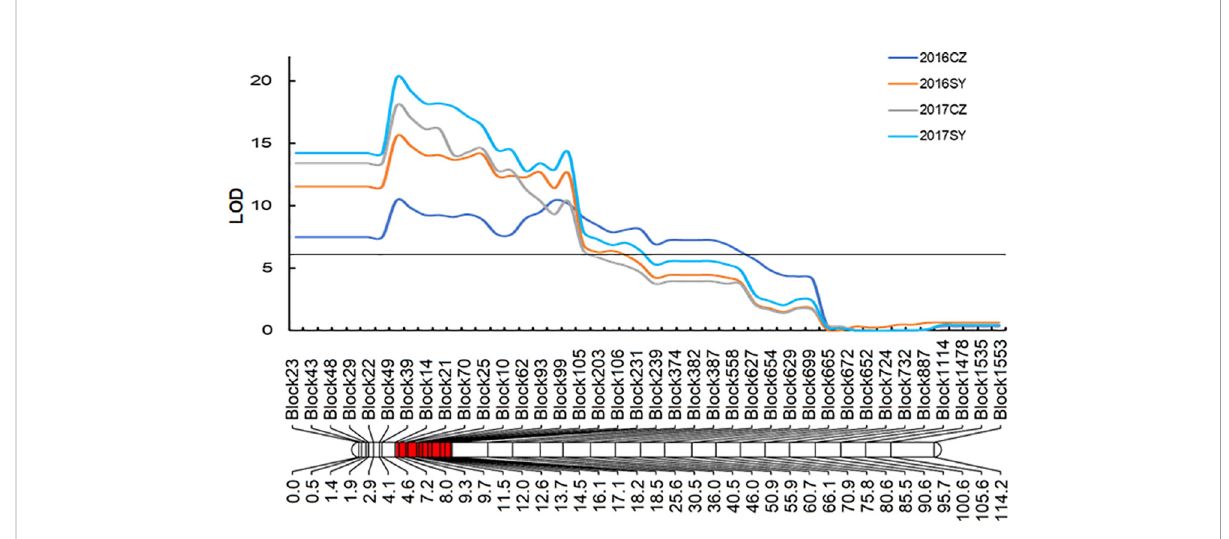
FIGURE 3 Genetic linkage of QHC-czas1 on chromosome 1 conferring brown hull color of Jigu 31. CZ, Cangzhou site; SY, Sanya site.